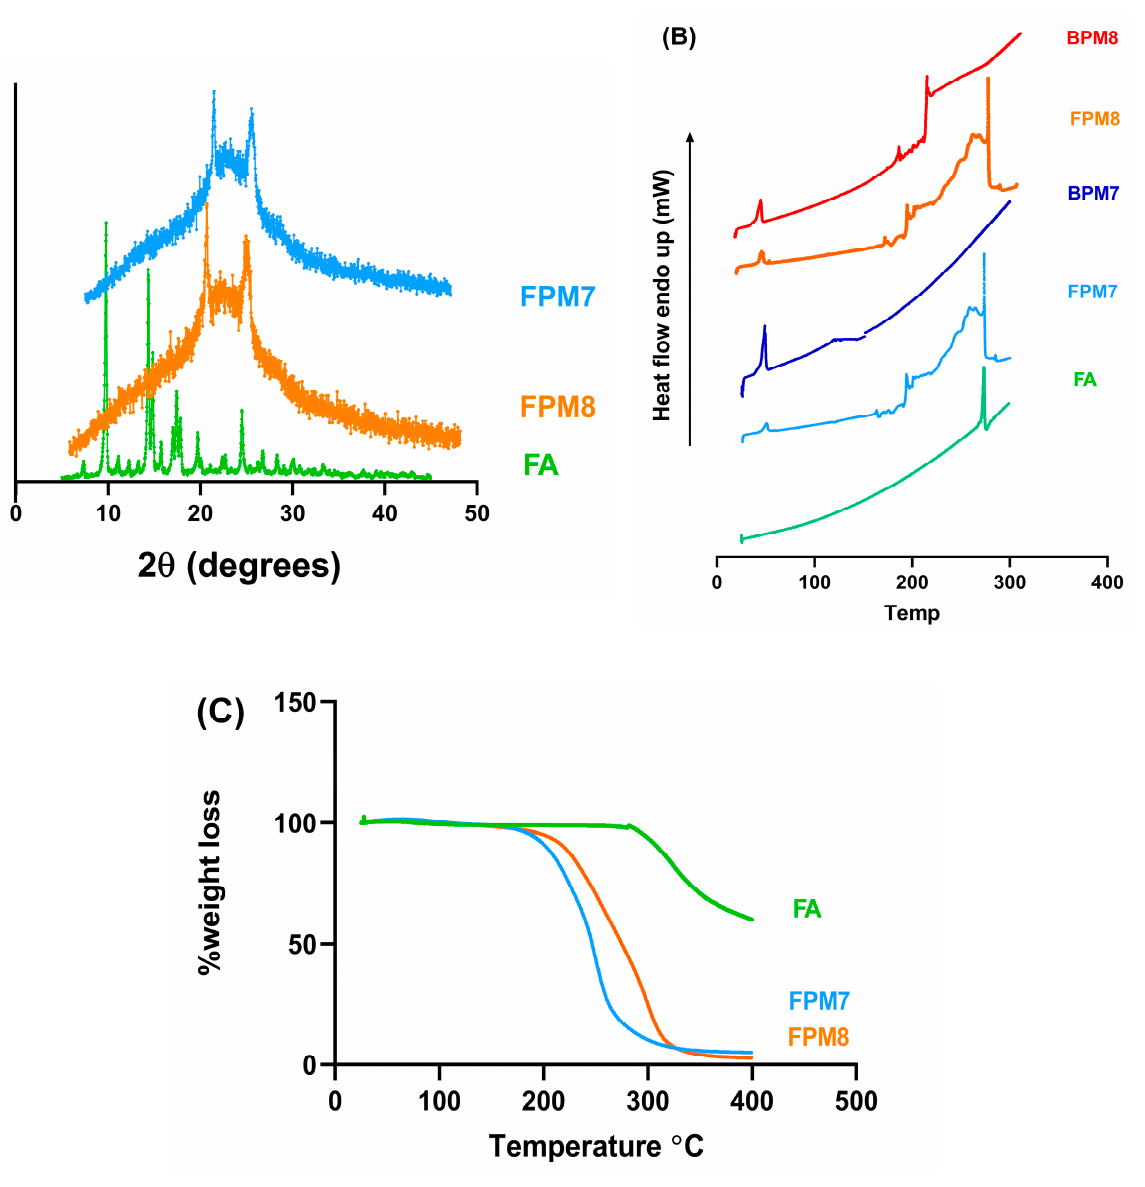
Figure 5. Physical characteristics of fluocinolone acetonide (FA) polymeric micelles: XRD ( A ), DSC ( B ), and TGA ( C ) thermograms.